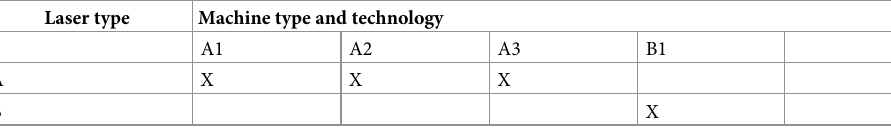
Table 6. Available types of technology.